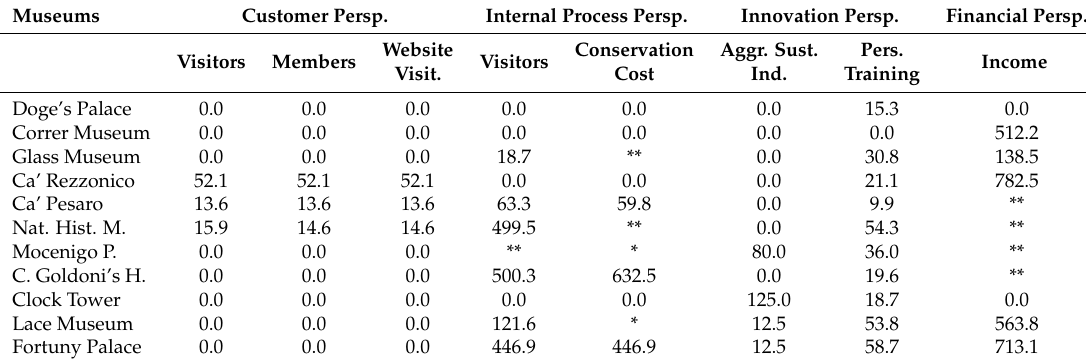
Table 9. Output improvements (percentage) that can be obtained by projecting each museum onto the efficient frontier for the DEA-BSC models of the different four perspectives in the first stage. Museums Customer Persp.